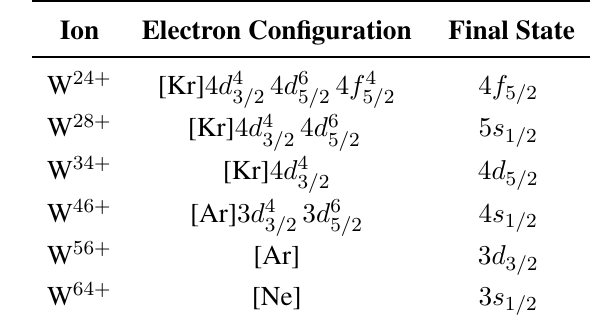
Table 3. Electron configurations adopted for recombining tungsten ions given in Figure 8 and the electron state in which an electron is captured.